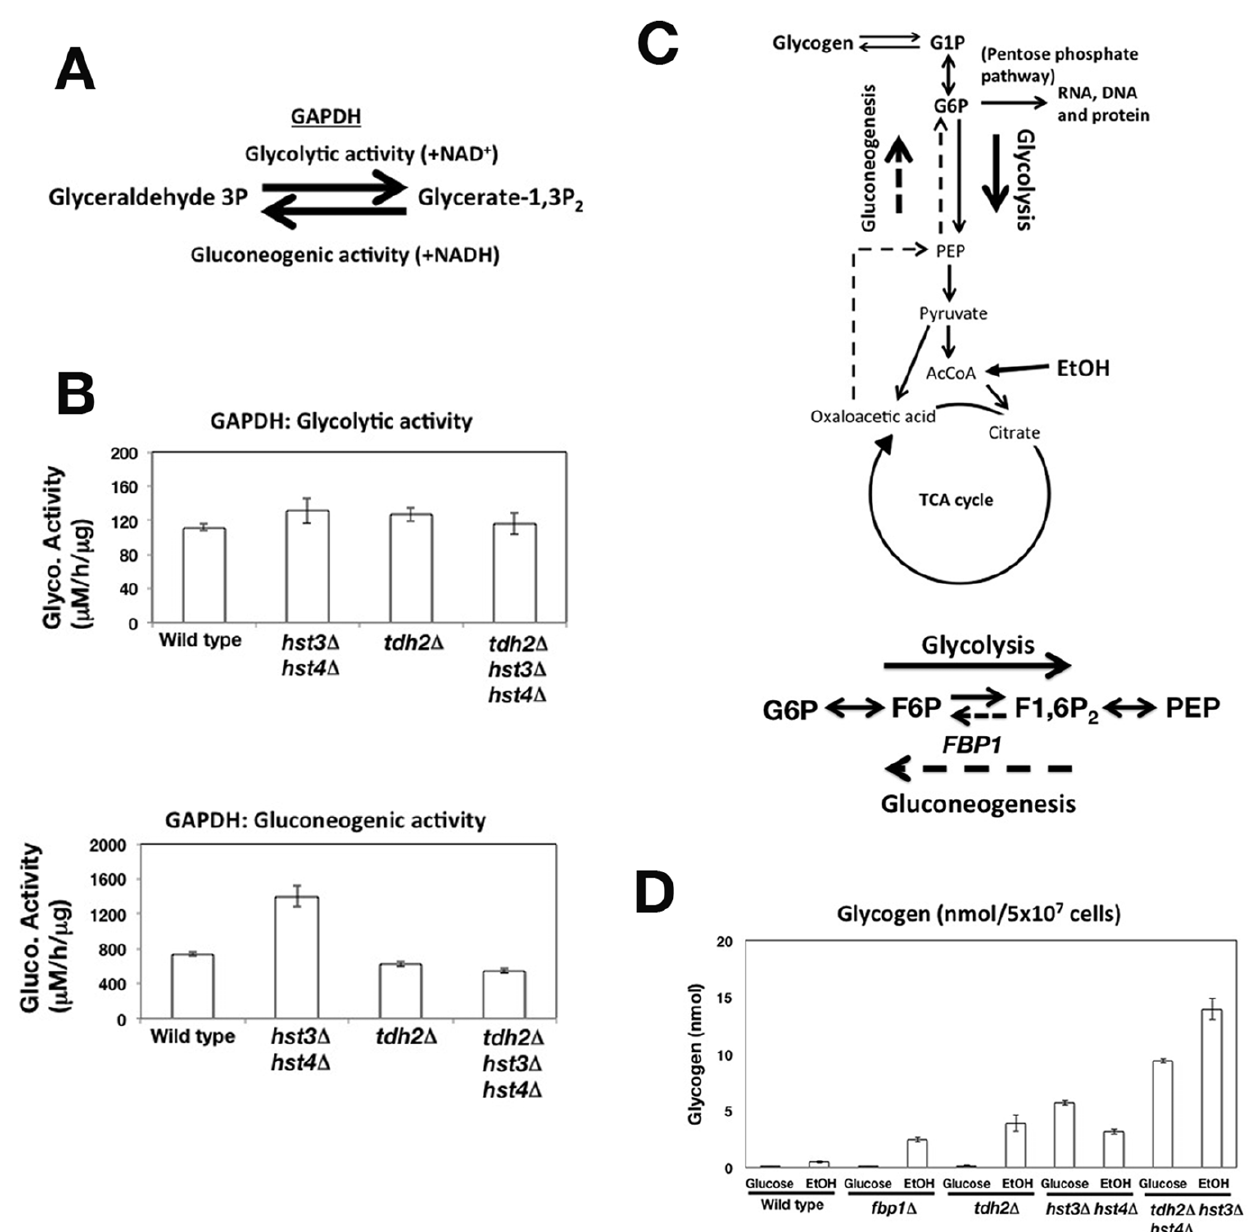
Figure 4. Deletion of the TDH2 gene can selectively repress the activation of gluconeogenesis. (A) The roles of GAPDH in both glycolysis and gluconeogenesis. (B) Measurement of GAPDH activity. The glycolytic and gluconeogenic activities of GAPDH were monitored using cell lysates prepared from asynchronous cells. (C) A cartoon showing the utilization of ethanol (EtOH) as a non-fermentative carbon source via gluconeogenesis. (D) Glycogen accumulates in gluconeogenesis-deficient cells ( fbp1 D ) and tdh2 D cells. The amount of glycogen prepared from cells cultured in liquid medium containing either glucose or EtOH was quantified. All graphs show the mean values of measurements performed in triplicate. The error bars denote the standard deviation. Note that certain error bars are too small to be